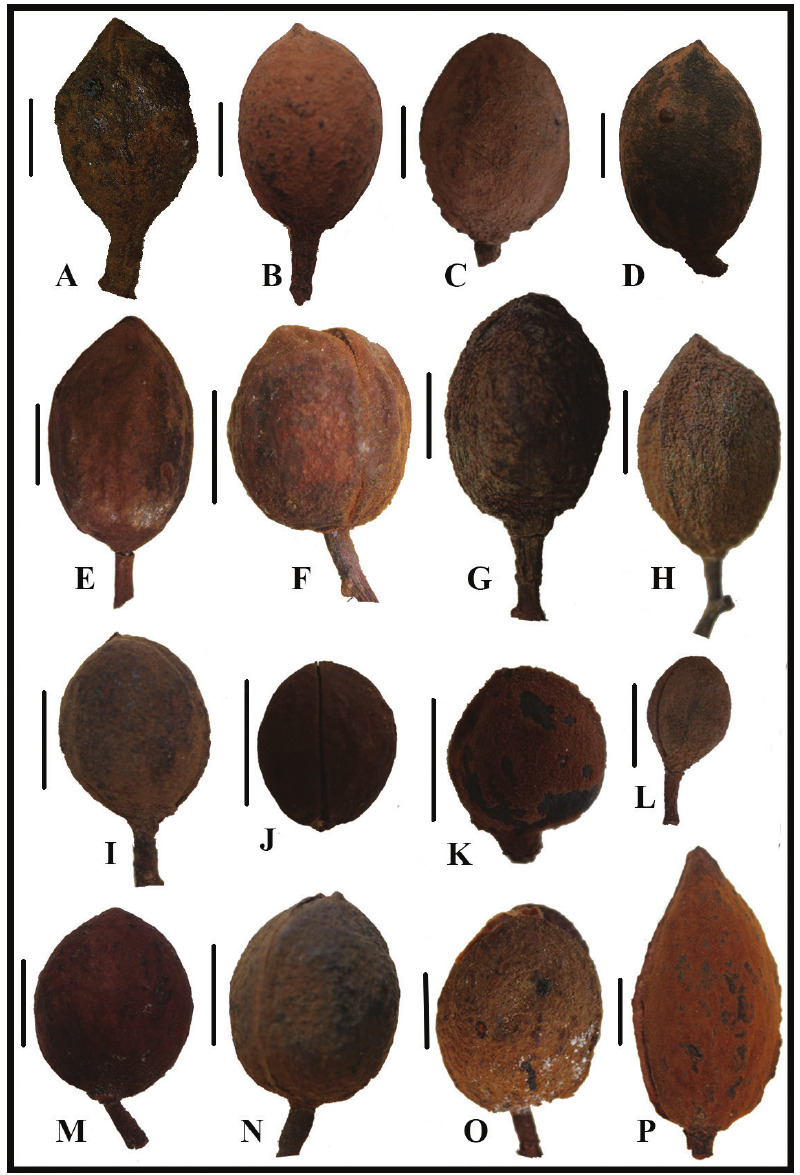
Figure 4. Fruits of Mesoameican Virola, organised in groups of morphologically similar species A V. al- lenii ( P. H. Allen 6727 , GH) B V. amistadensis ( G. McPherson 9715 , MO) C V. otobifolia ( A. Gentry & S. Mori 14199, MO) D V. macrocarpa ( A. E. Lawrance 675, MO) E V. chrysocarpa ( B. Hammel et al.16864 , MO) F V. koschnyi ( R. Robles 1587, MO) G V. guatemalensis ( S. Sinaca 1542 , MO) H V. montana ( J. Utley & K. Utley 5054, MO) I V. fosteri ( S. Mori & J. Kallunki 4891 , MO) J V. multiflora ( R. Rueda et a.l 9960 , MO) K V. sebifera ( T. B. Croat 5959 , MO) L V. elongata ( J. D. Dwyer & M. Correa 8420 , MO) M V. laevi- gata ( R. Aguilar 1585 , MO) N V. nobilis from Barro Colorado ( T. B. Croat 8090 , MO) O V. nobilis from the Osa Peninsula ( G. Herrera 4222 , MO) P V. megacarpa ( G. de Nevers 5184 , MO). Scale bars: 1